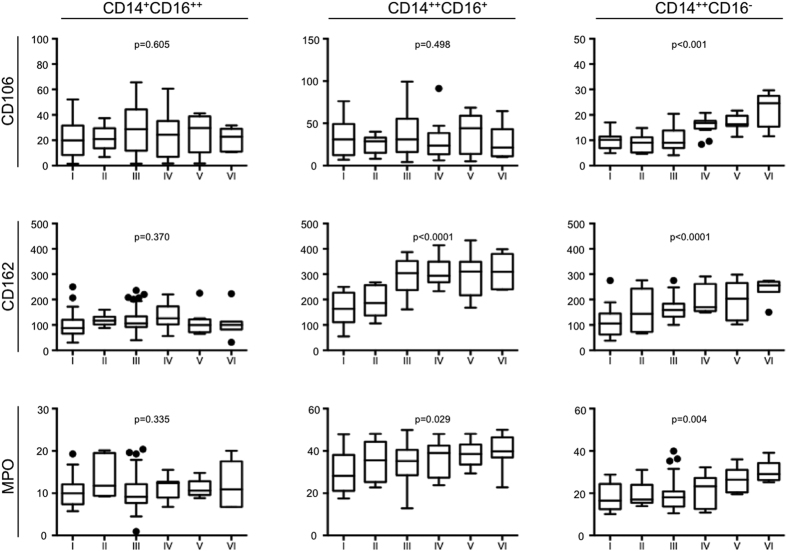
CD106, CD162 and MPO expression in monocyte subsets.Surface expression of CD106/VCAM-1 (Panel A) and CD162/PSGL-1 (B) and MPO content (C) were assessed by flow cytometry in each of the three monocyte subsets. Significant increase/decrease of biomarker expression/content are indicated by a p-value < 0.05. Data are presented as box plots, outliers are shown as single dots. Sample sizes are: Rutherford stage I: n = 24, II: n = 8, III: n = 74, IV: n = 16, V: n = 13, VI: n = 8.